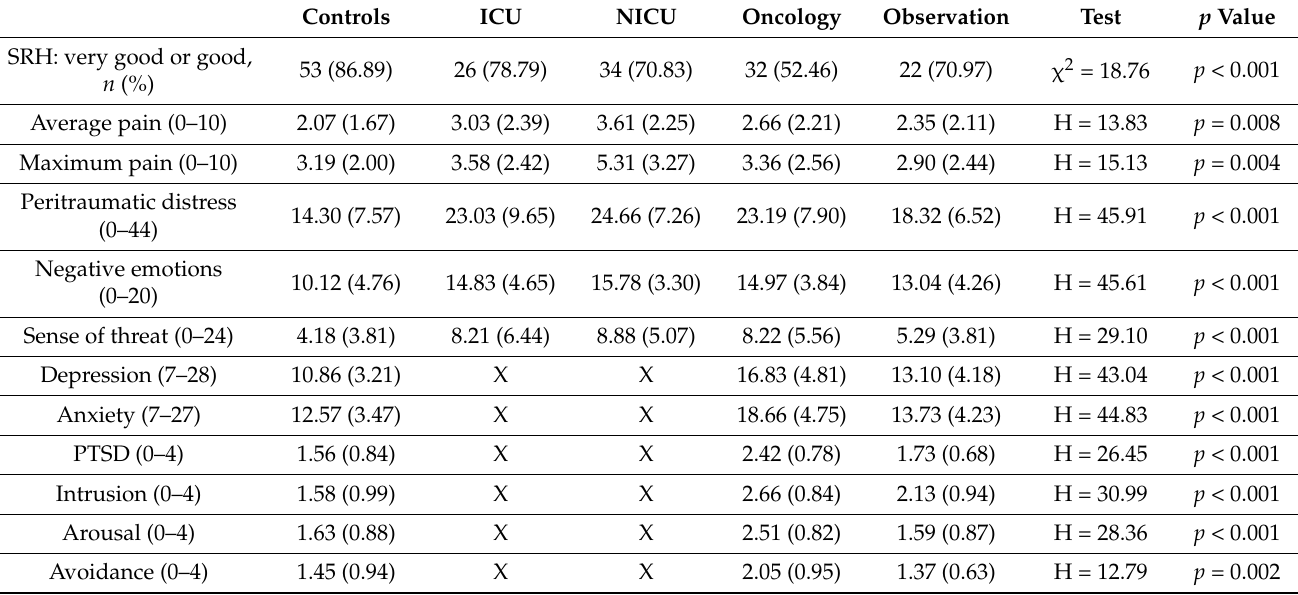
Table 2. A comparison of groups distinguished by the place of hospitalization of the child with respect to selected biopsychosocial welfare features of mothers of healthy children and those requiring outpatient observation or hospitalization. Controls ICU NICU Oncology Observation Test p